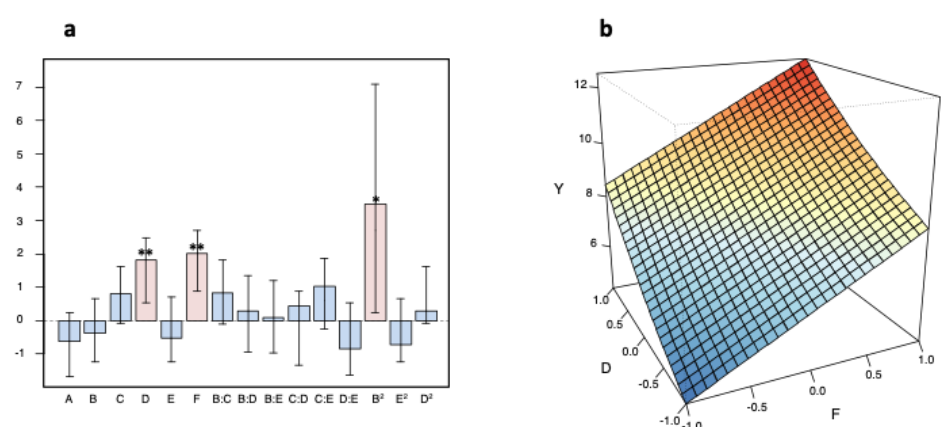
Figure 4. ( a ) Plot of the coefficients (whiskers indicate the confidence interval at p = 0.05; *= p < 0.05, **= p < 0.01; ***= p < 0.001); the y -axis (dimensionless) shows the magnitude of the coefficients, which is identical to the coefficient values reported in Equation (1). Experimental factors are coded as reported in Table 1. B:C, B:D, B:E, C:D, C:E, and D:E, are the two-term interactions. ( b ) Response (Y) predicted by the experimental design model as a function of D (centrifugation time) and F (drying time after centrifugation), while keeping A = 0 (10 min), B = 1 (150 “L), C = 0 (10 min), and E = 0 (8000 rpm).